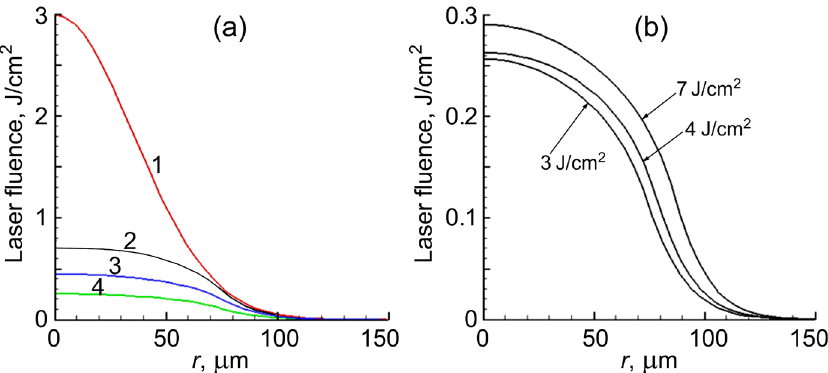
Figure 4. ( a ) Calculated radial distributions of laser fluence on a platinum target surface located at the beam focus for the experimental conditions reported in [17,18].